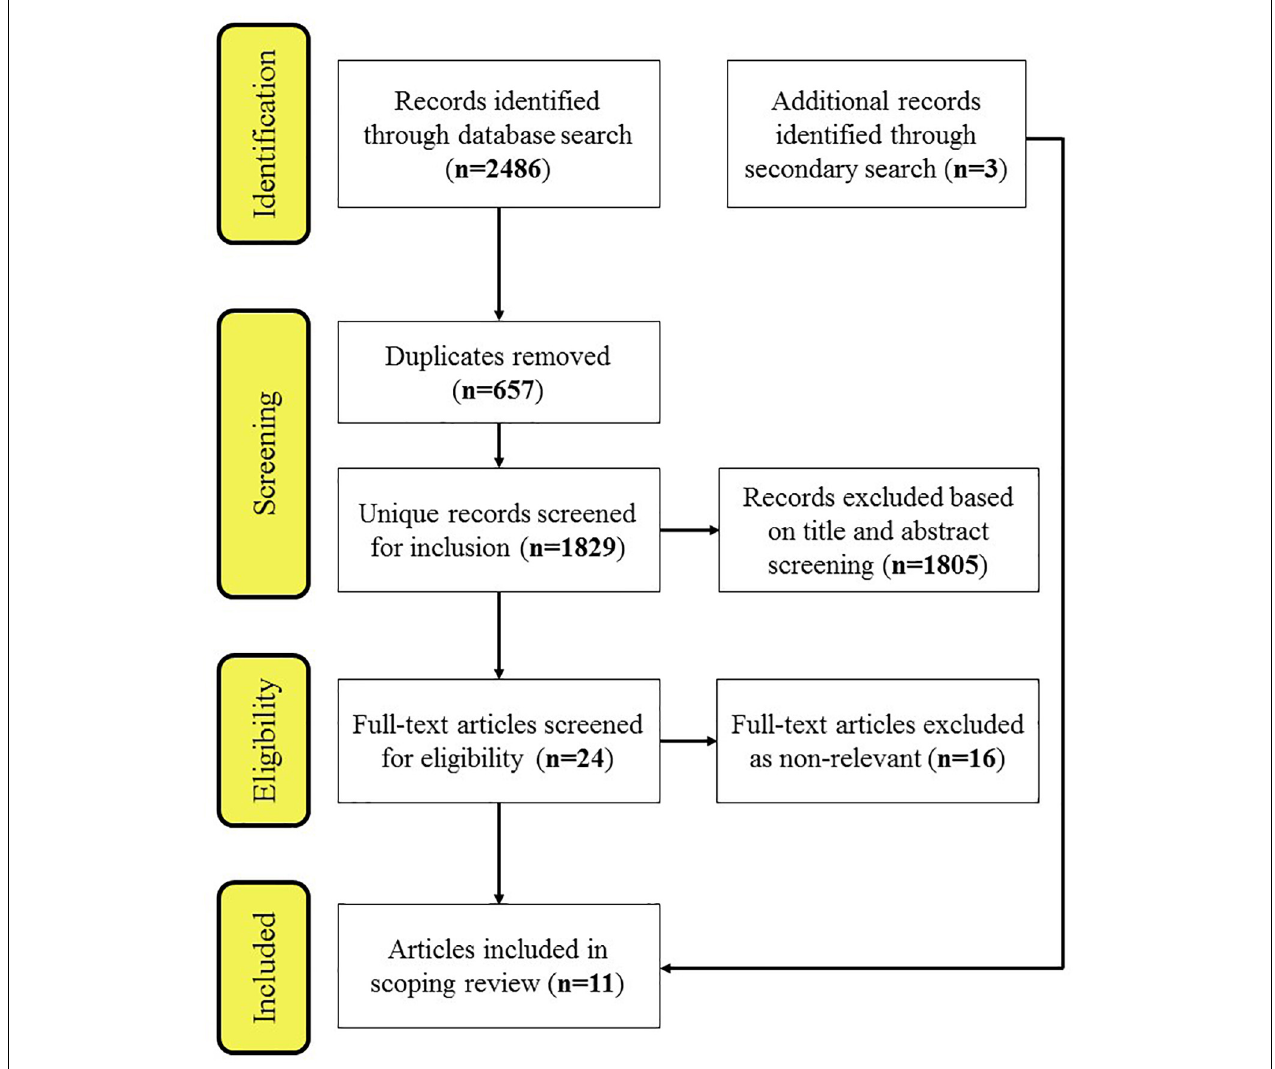
FIGURE 1 | Study search process including (a) initial identification, (b) screening based on title and abstracts, (c) checking full-text articles against inclusion criteria, and (d) the final reviewed